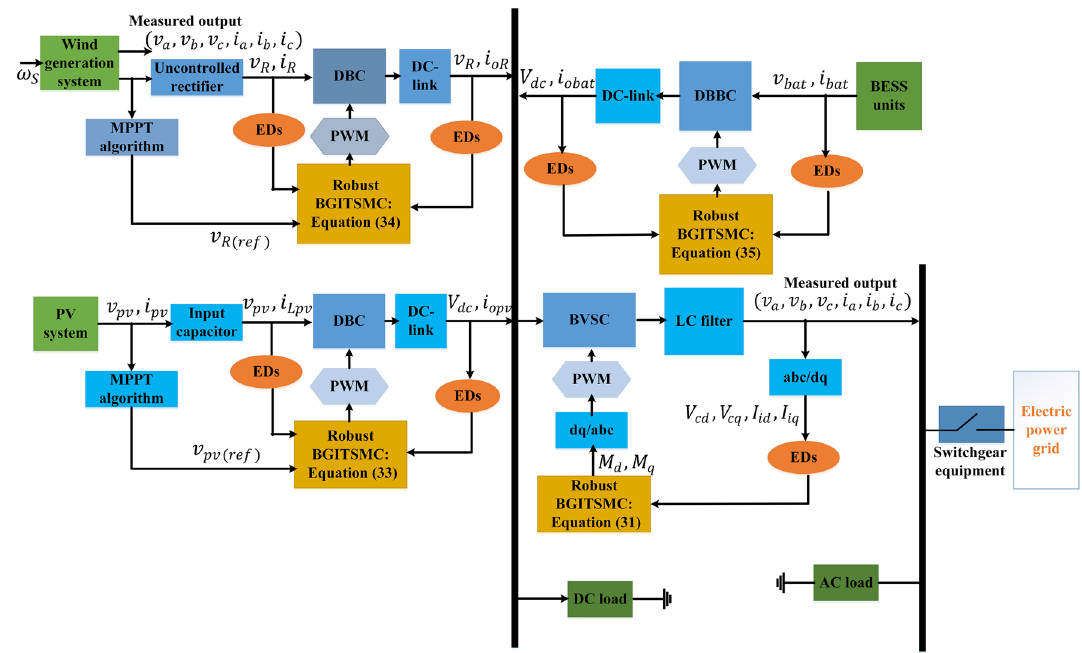
Fig. 6 Implementation block diagram of the proposed control